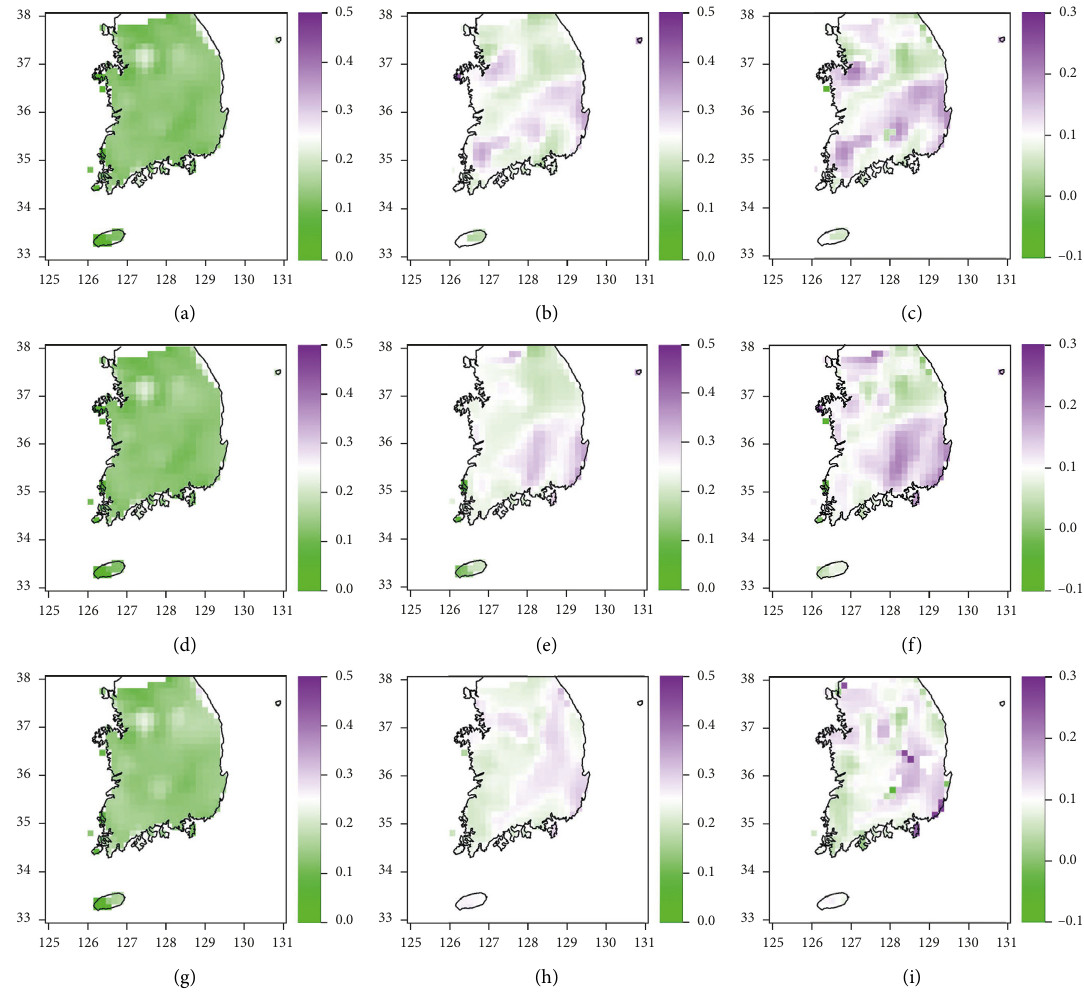
Figure 4: Coefficient of variation of 20-year return value of annual maximum daily precipitation for CMIP5 26 GCMs corrected by SDQM ((a), (b), and (c)), SD-DQM ((d), (e), and (f)), and SD-QDM ((g), (h), and (i)) for the reference ((a), (d), and (g)), Future3 period ((b), (e), and (h)), and the difference between reference and Future3 period in percentage ((c), (f), and (i)). Table 3: Coefficient of variation of 20-year precipitation under reference, Future1, Future2, and Future3 period for South Korea. Reference Future1